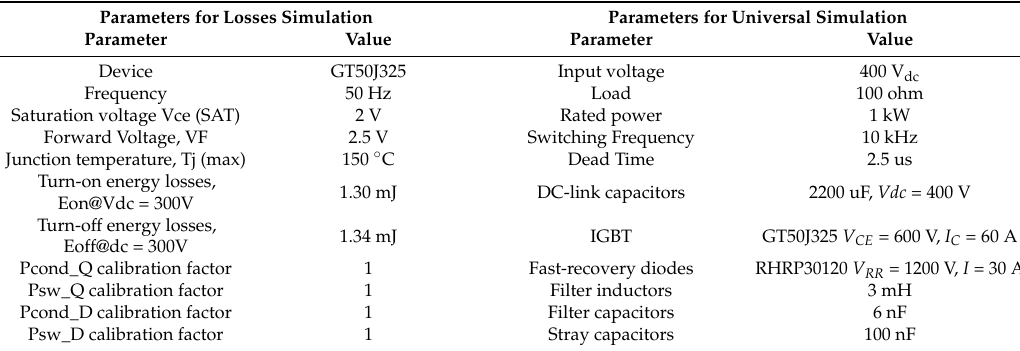
Table 3. Specification for loss